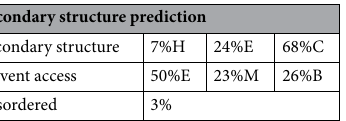
Table 4. Secondary structure prediction of multi-epitopes vaccine using RaptorX 14 .